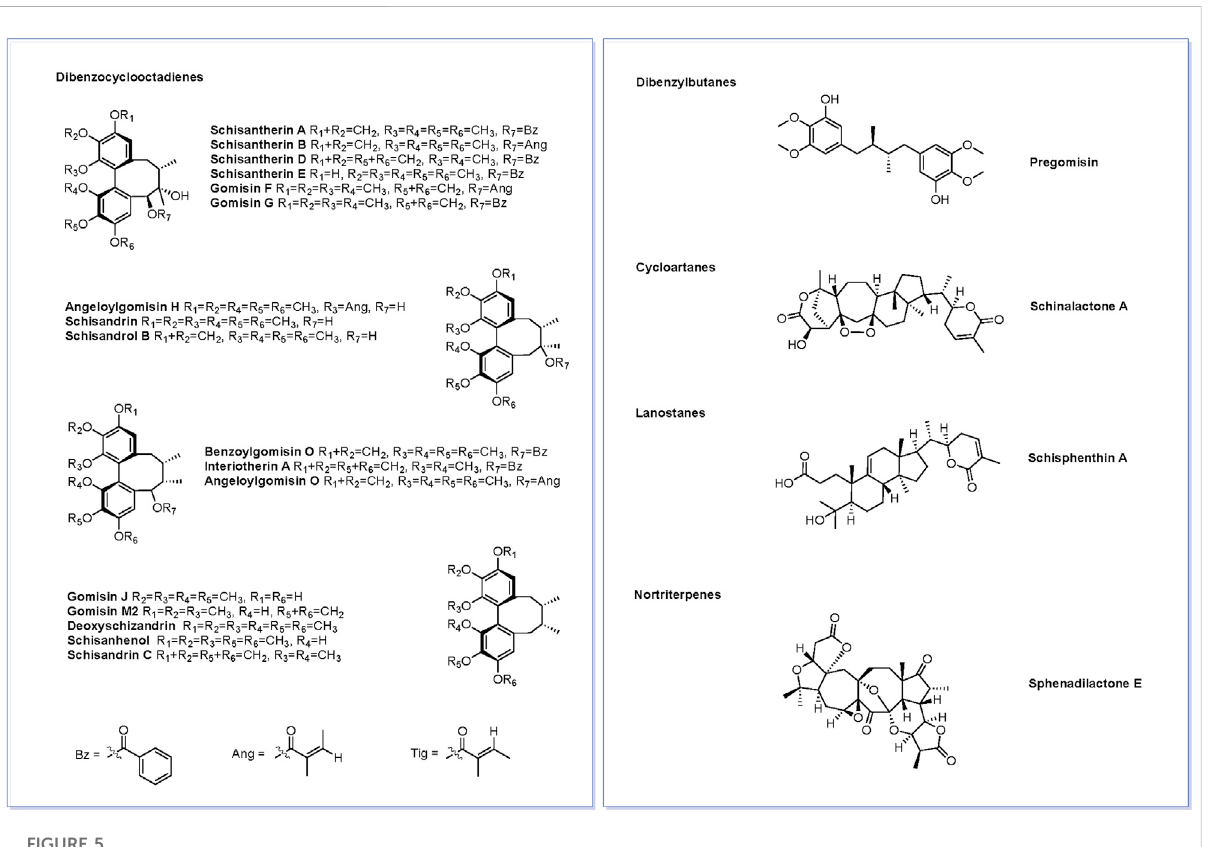
FIGURE 5 Structures of 21 active compounds screened based on the